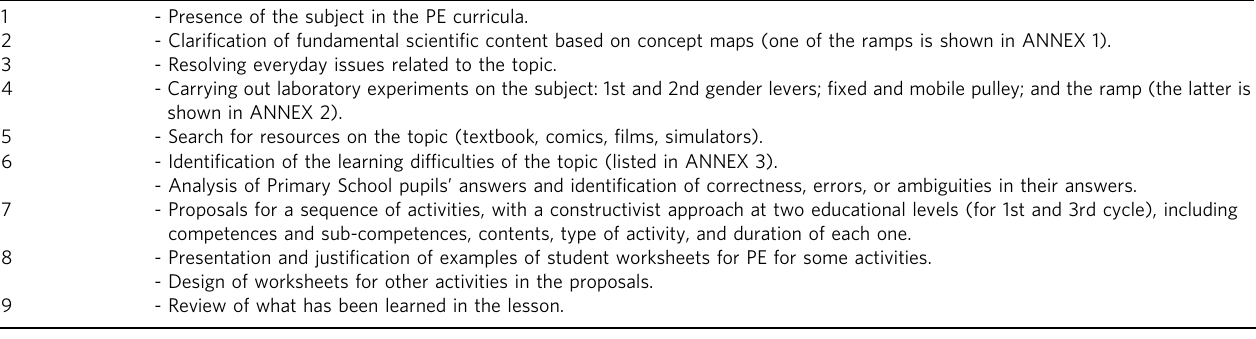
Table 3 Teaching sequence on the ramps.